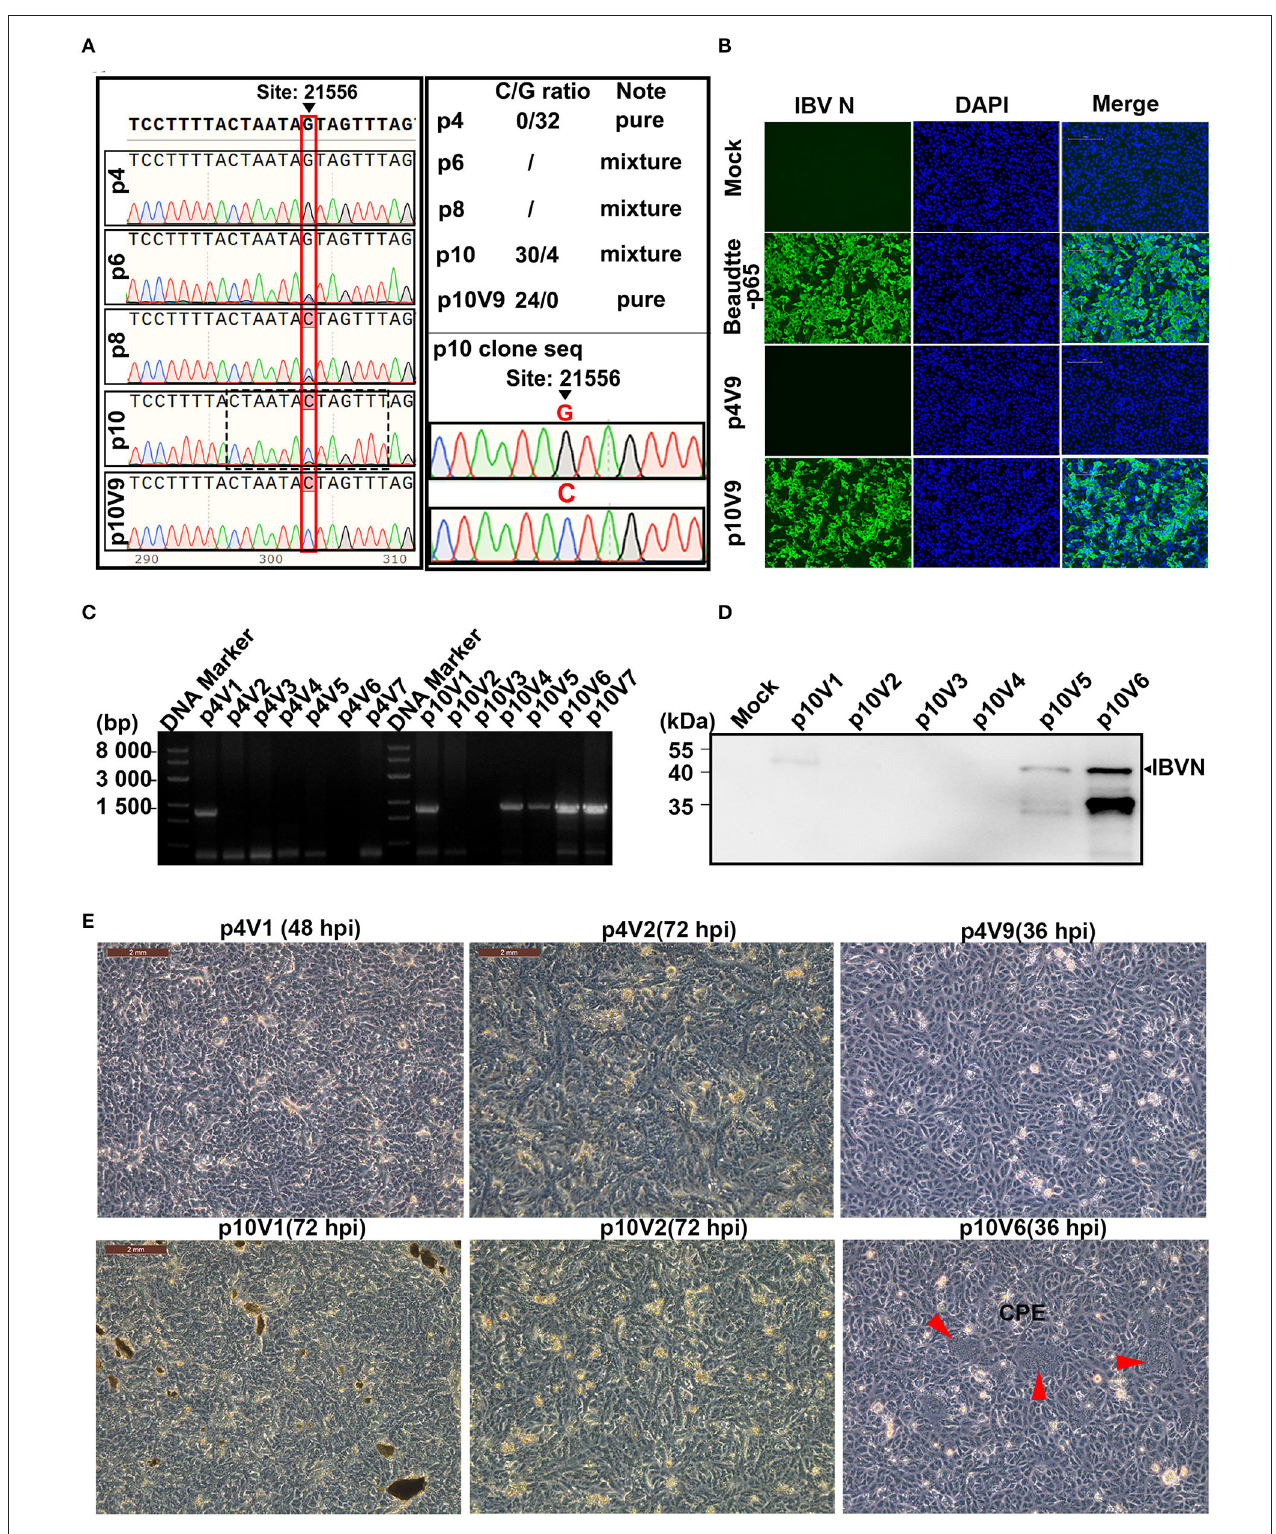
FIGURE 2 | Effects of G21556C (S248T) point mutation in the S1 region on the cultivability of rIBV-Beau-KC(S1) in Vero cells. (A) Emergence and accumulation of G21556C mutation during the passage of rIBV-Beau-KC(S1) in chicken embryos. The regions covering the G21556C point mutation from p4, p6, p8, p10, and p10V9 were sequenced, showing double peaks of G and C in p6, p8, and p10. Mixed clones containing both G and C at the nucleotide position 21,556 were found in the 30